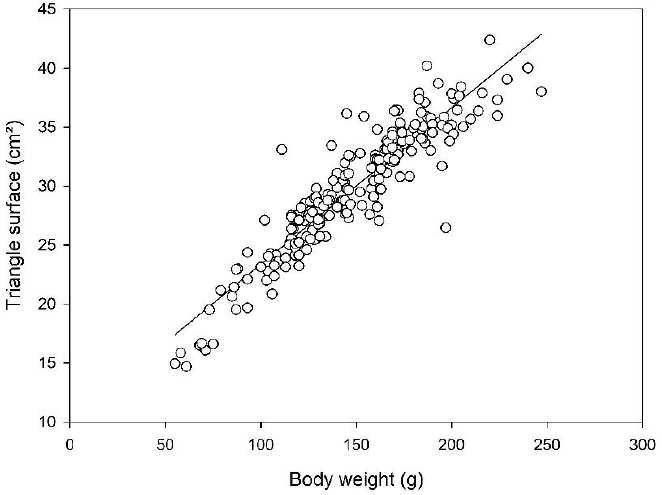
Figure 5. Strong linear correlation between body weight ( x -axis) and triangular surface ( y -axis) of female adult Xenopus laevis frogs ( n = 198; y = 0.13x + 10.11; R 2 = 0.85).